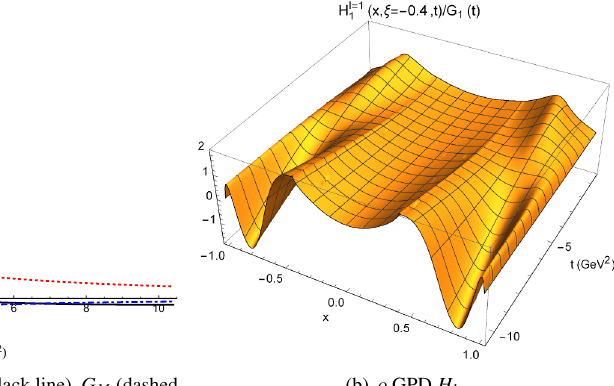
(a) ρ form factors, G C (solid black line), G M (dashed red line) and G Q (dot-dashed blue line)